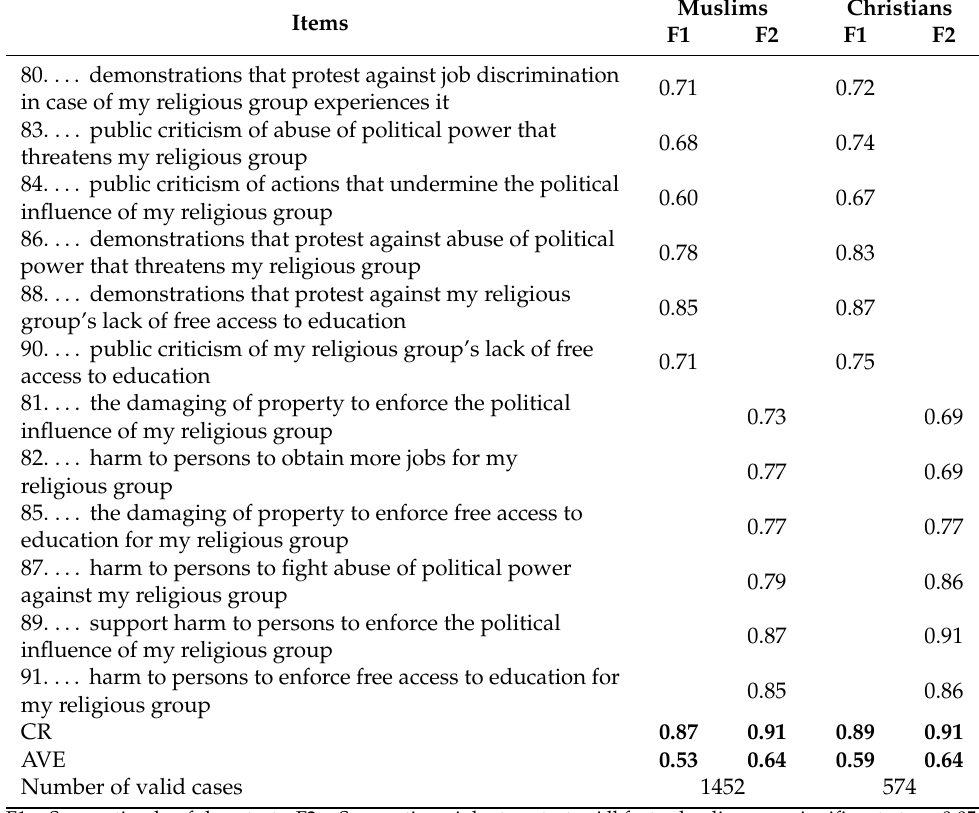
Table A1. Factor loadings for two-factor confirmatory model of supporting interreligious